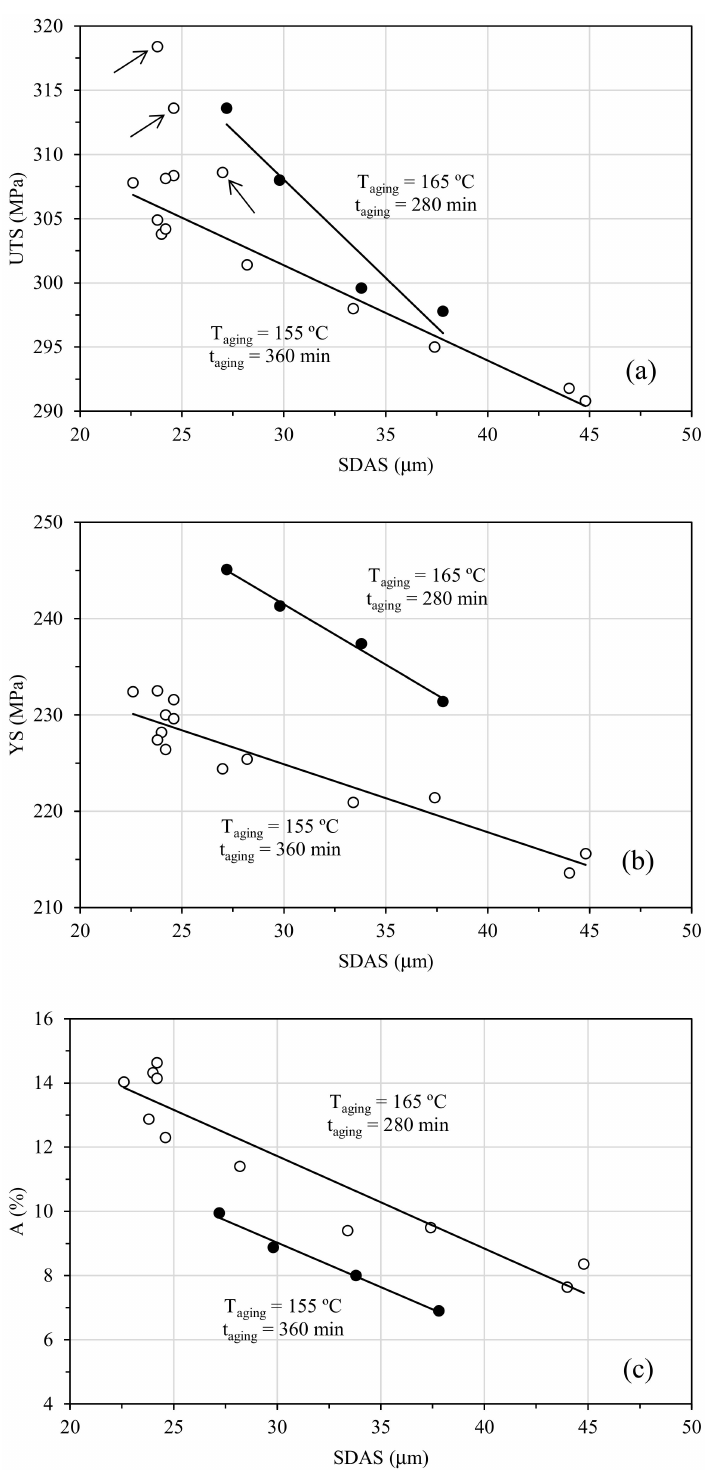
Figure 11. Evolution of UTS ( a ), YS ( b ) and A ( c ) with the experimental SDAS in castings SK-1 (solid circles) and in castings SK-2 to SK-6 (open